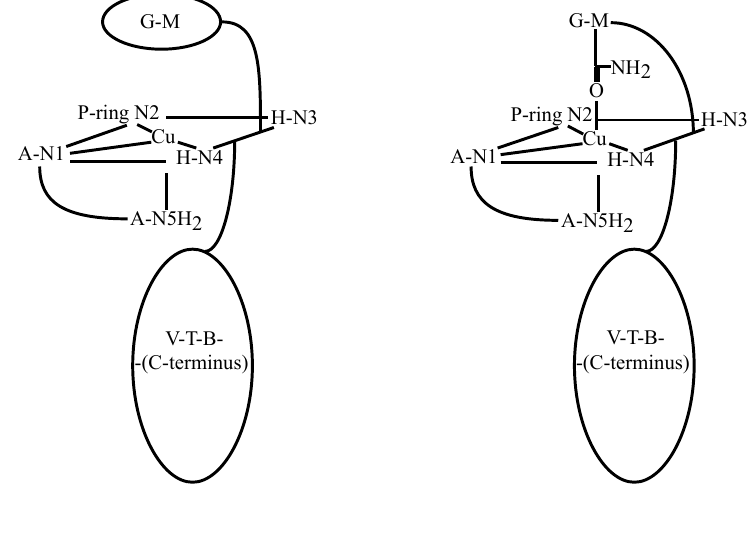
Figure 10. Cu(I)-coordination models proposed for Cu(I)BLM by Lehmann